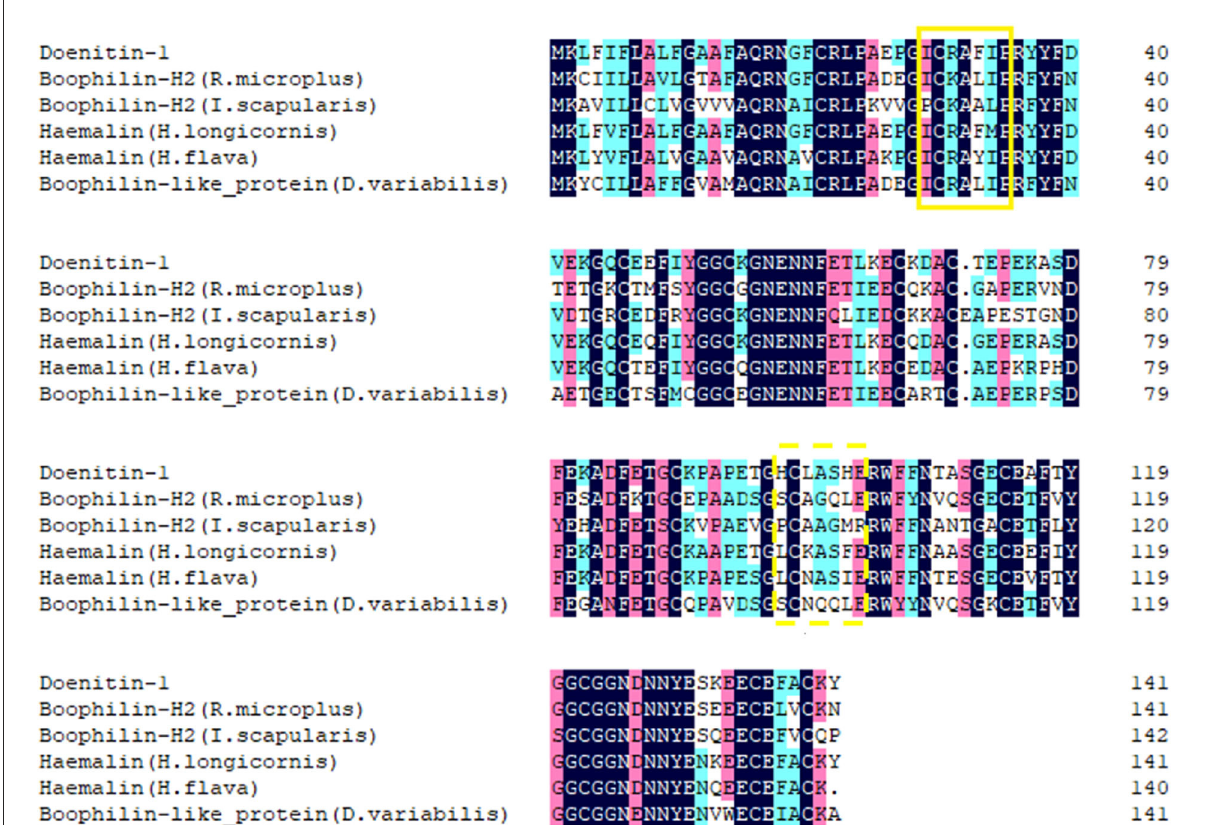
FIGURE2 Alignment of Doenitin-1 with its homologs in other tick species. The identical amino acid sequence is in the last row. The solid yellow box is the BPTI/Kunitz substrate binding presenting loop; the yellow dotted box is the Kunitz/Bovine pancreatic trypsin binding presenting loop. The black highlight homology level equals 100%, the pink highlight homology level is greater than or equal to 75%, the blue is greater than or equal to